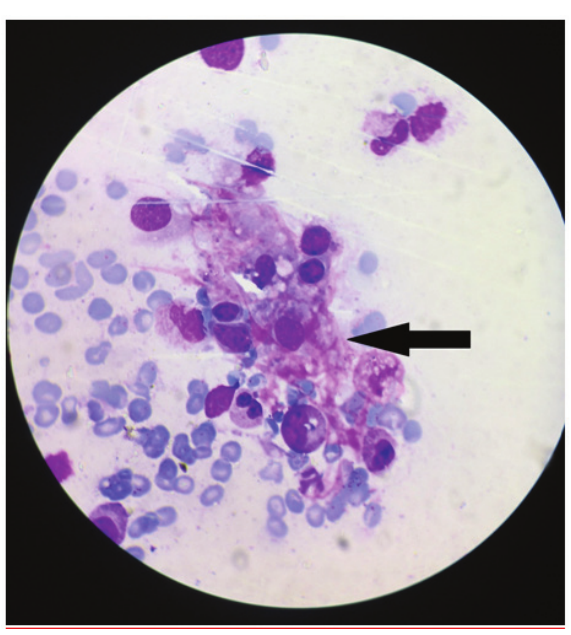
Table 1: Laboratory data of our patient at